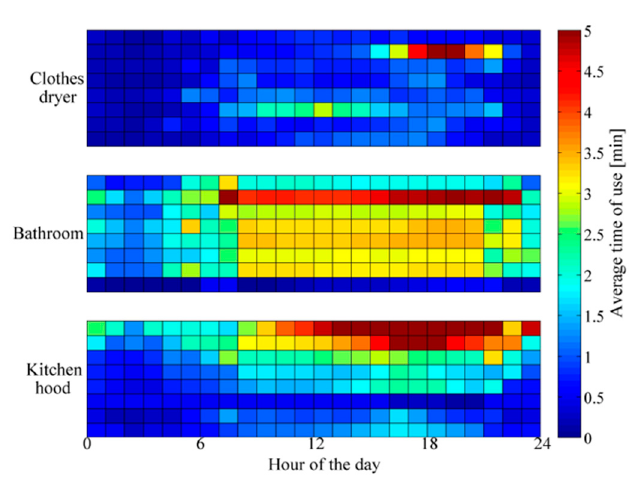
Figure 1. Average use at each hour of the day of the kitchen hood, bathroom and clothes dryer exhaust fans in eight dwellings.